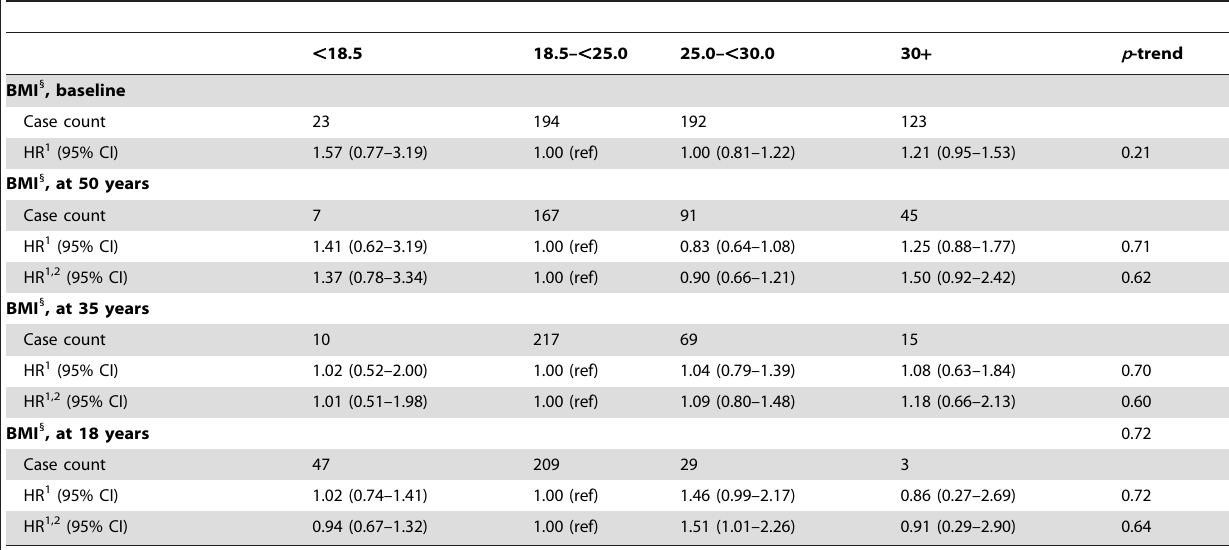
Table 2. Hazard ratios (HR)and 95% confidence intervals (CI) for body mass index (BMI) at various ages and lung cancer risk among never smokers, NIH-AARP Diet and Health Study (1995–2006).